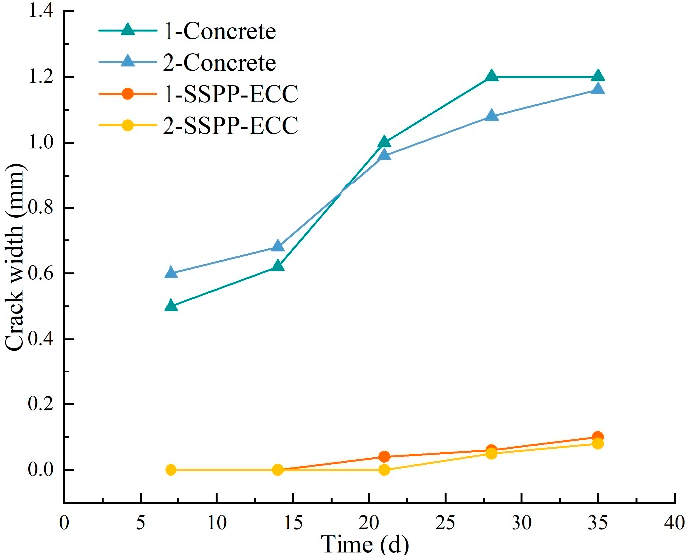
Figure 20. Crack width of concrete and SSPP-ECC at different times.